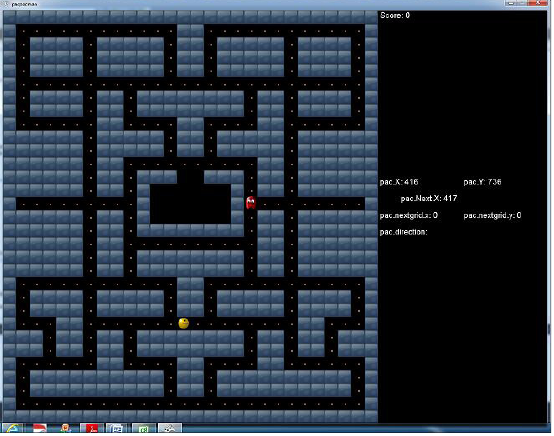
Figure 3. Environment (Pac